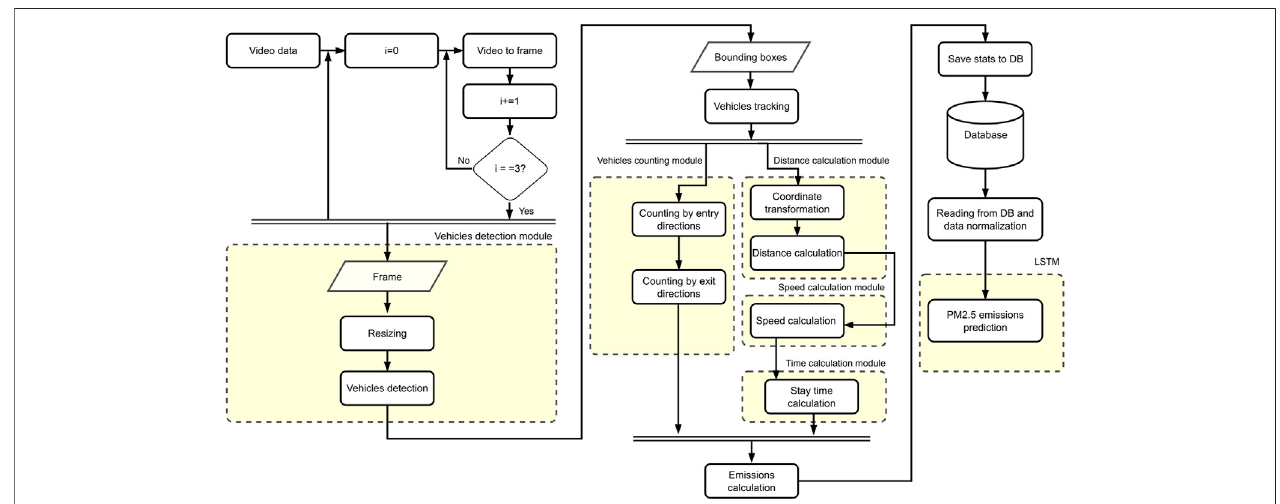
FIGURE 1 | An algorithm of a hybrid model for vehicle